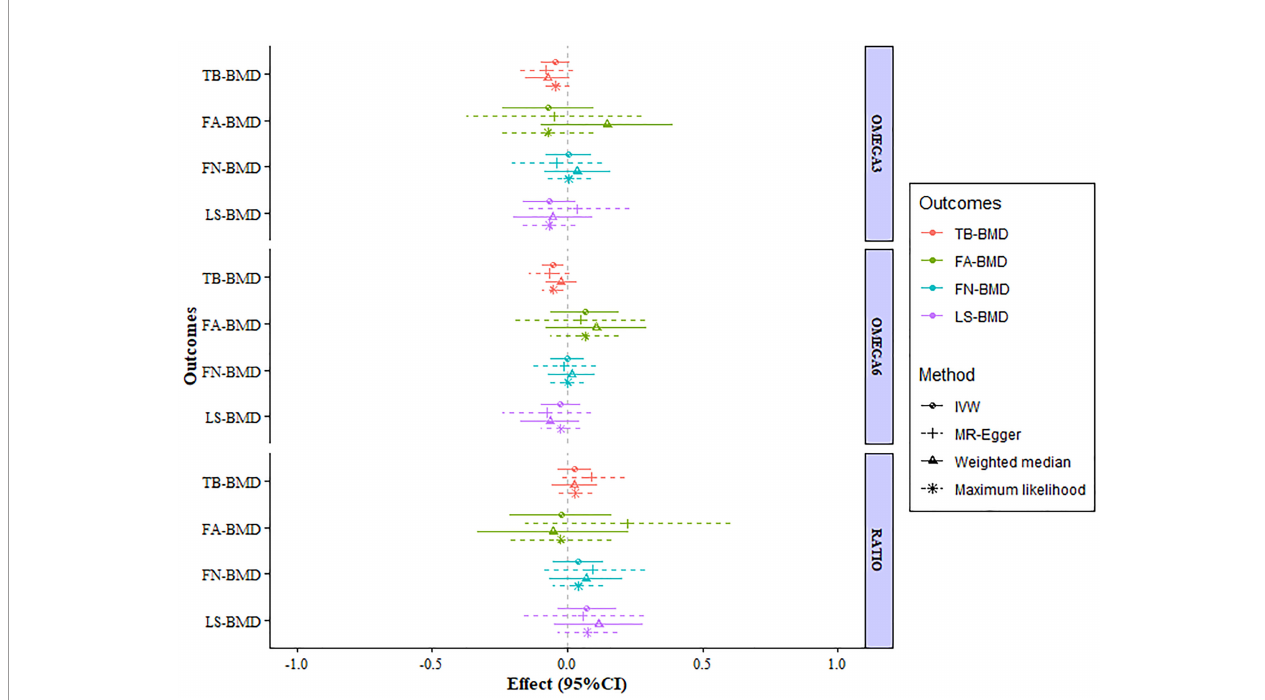
FIGURE 1 | MR estimates of the associations between PUFAs and BMD. The x-axis is the effects of PUFAs on BMD values. The vertical dashed line is the reference at effect = 0. The y-axis presents different BMD types, which are highlighted in different colors. Different MR methods are displayed with different line types. MR, Mendelian randomization; BMD, bone mineral density; FN-BMD, femoral neck BMD; LS-BMD, lumbar spine BMD; FA-BMD, forearm BMD; TB-BMD, total body BMD; SNPs, single nucleotide polymorphisms; IVW, inverse variance weighted; SE, standard error; CI, con fi dence